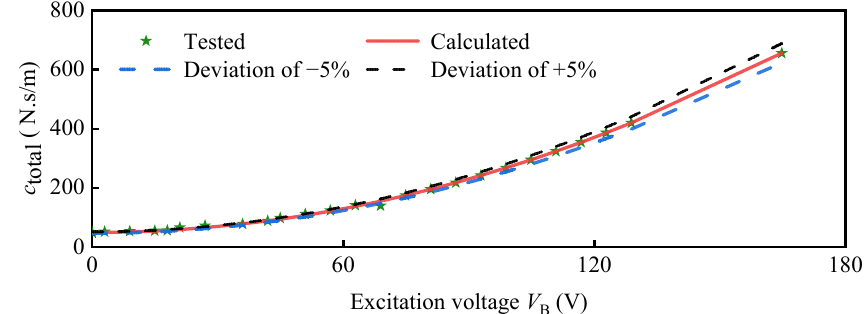
Figure 4. Deviations of the tested total damping with the calculated total damping.